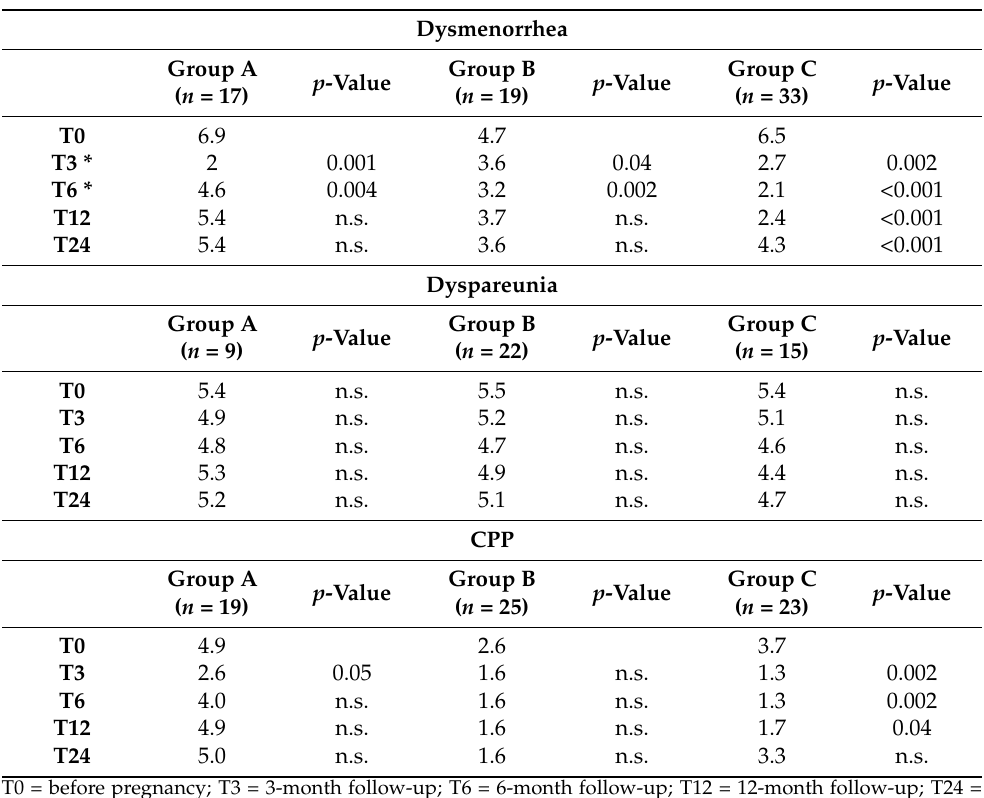
Table 2. Median VAS score before pregnancy and at follow-up compared to the months of breastfeed- ing of the 96 patients who exclusively breastfed.